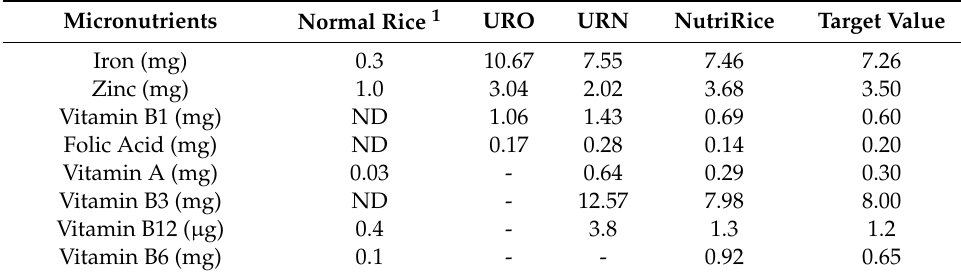
Table 1. Micronutrient contents of normal rice, and the actual and target values of the di ff erent types of fortified rice, per 100g of uncooked blended